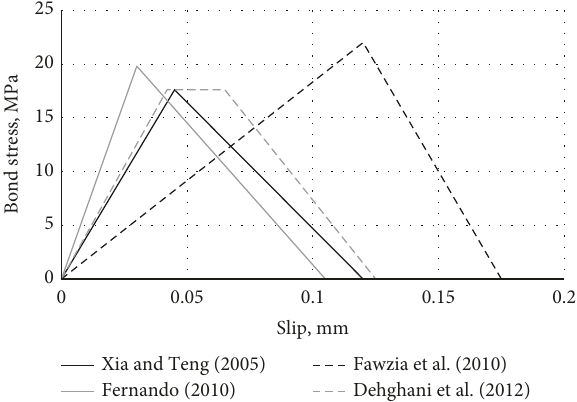
Figure 1: Existing bond-slip models for FRP-steel